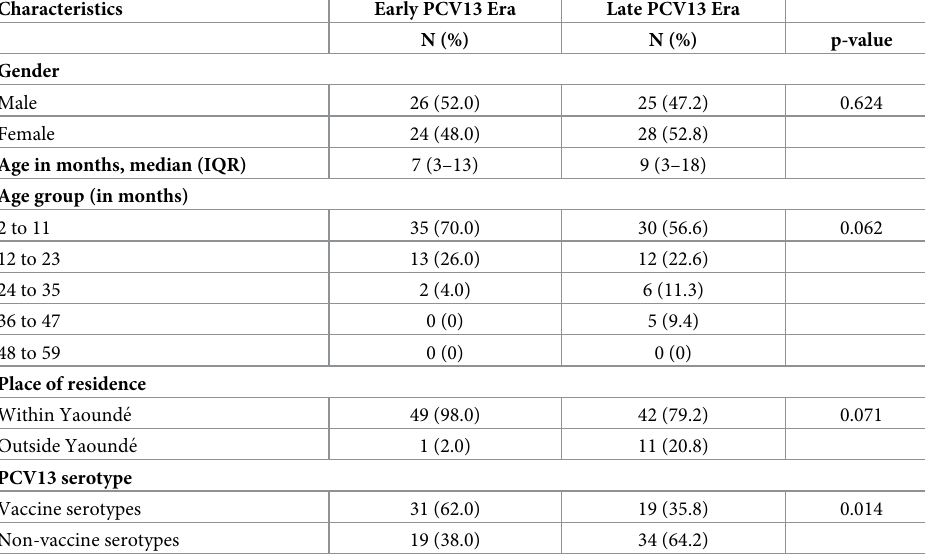
PCV13 = 13-valent pneumococcal conjugate vaccine; N = number; % = Percentage; p-value were computed using the Pearson’s Chi-square Test; IQR = Interquartile